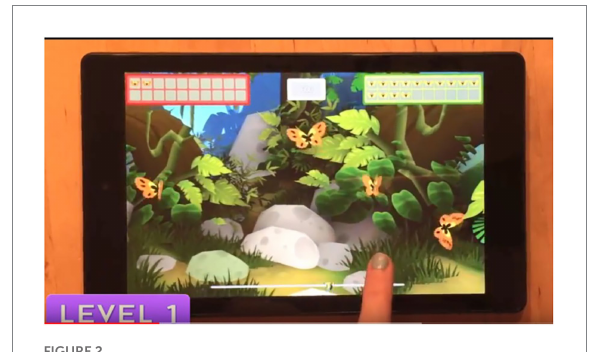
FIGURE 2 Screenshot of the Butterfly game on the tablet.